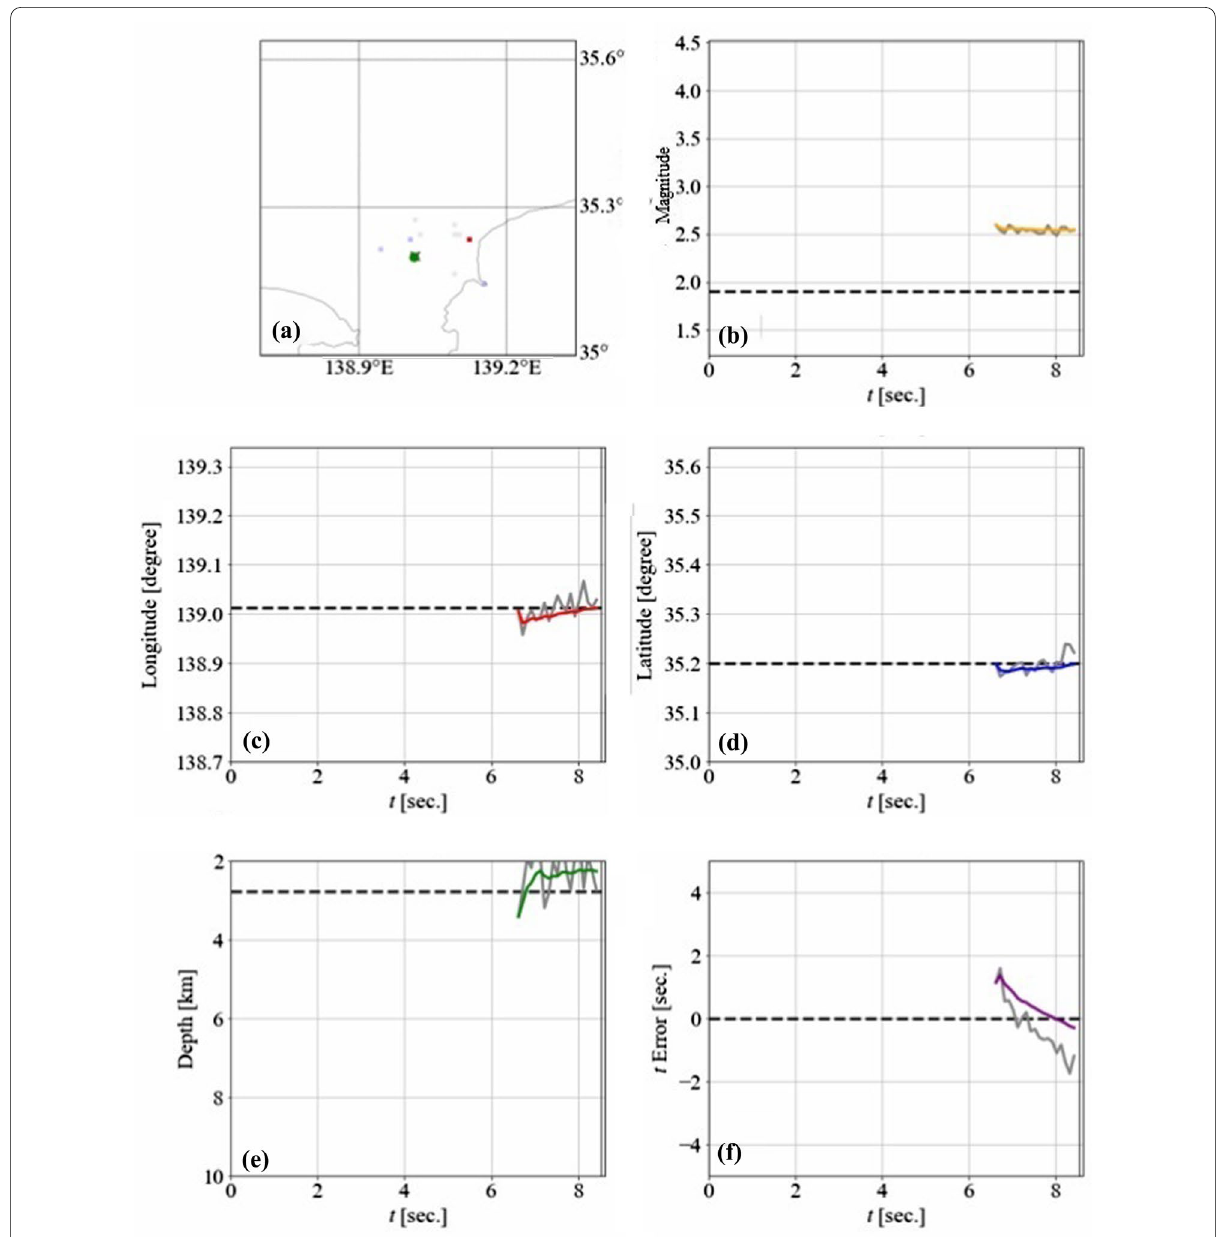
Fig. 5 Examples of hypocenter estimation in the verification phase for one earthquake (top left, a ) Seismic wave propagation images starting at approximately 6 s after the origin time. The time evolution of the estimated hypocenter parameters is shown for magnitude (top right, b ), longitude (middle left, c ), latitude (middle right, d ), depth (bottom left, e ) and origin time (bottom right, f ). The horizontal axis of each panel represents the time in seconds, and the estimation starts at approximately 6 s after the origin time when the absolute amplitude exceeds 1.0e line in each figure represents the parameter to be estimated by each snapshot. The gray line in each figure shows the value estimated using each snapshot. The colored line shows the average of the estimated value up to each time instant. It should be noted that in the verification of the latitude, shown in d , the estimated value is in agreement with the actual value, and the overlap of the three lines indicates that no differences